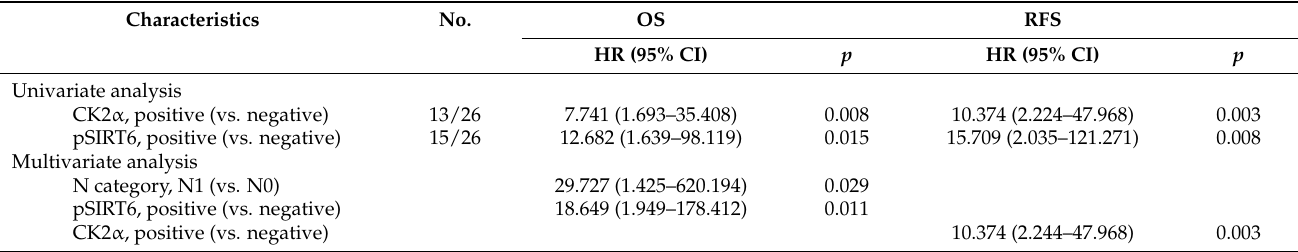
Table 4. Univariate and multivariate Cox proportional hazards regression analysis of the survival of 26 osteosarcoma patients who received adjuvant chemotherapy.